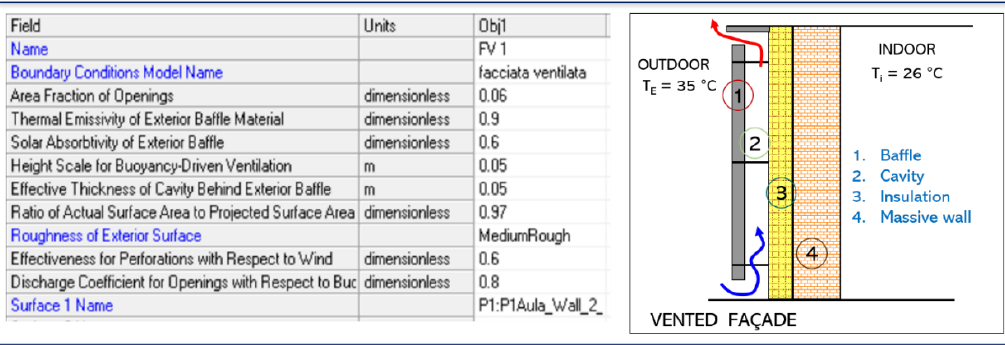
Figure 17. Energy-Plus model of the vented façade.